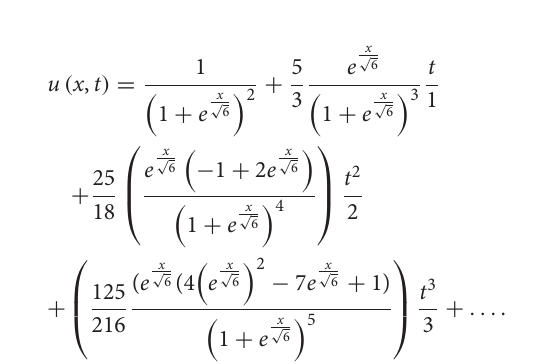
FIGURE 4 | Comparison of approx. sol. for different values of fractional order α and exact sol. at α 1, for Ex. =